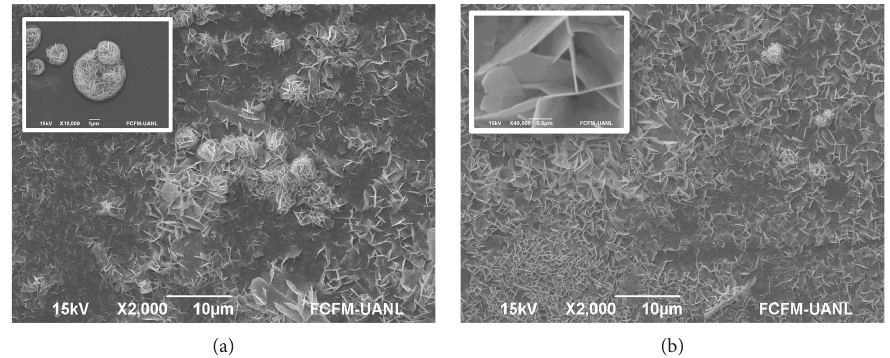
Figure 2: SEM micrographs corresponding to a BiOI thin film grown on a ZnO thin film. It is possible to observe different stages of growth: (a) the growth of rounded grains and their overlapping and (b) microplatelets grown in perpendicular direction to the substrate